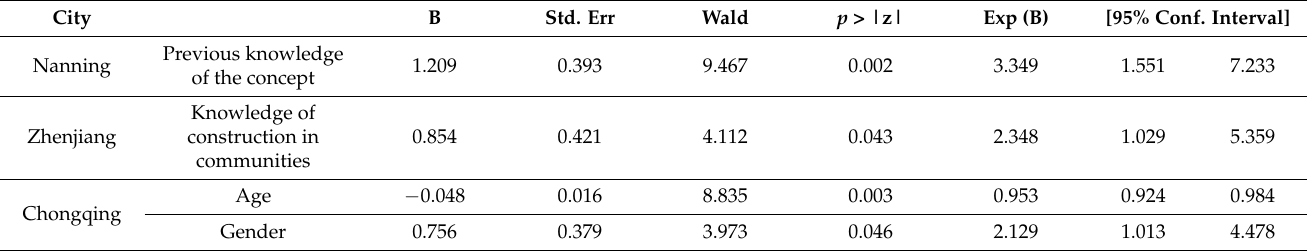
Table 4. Factors influencing respondents’ WTP for urban green